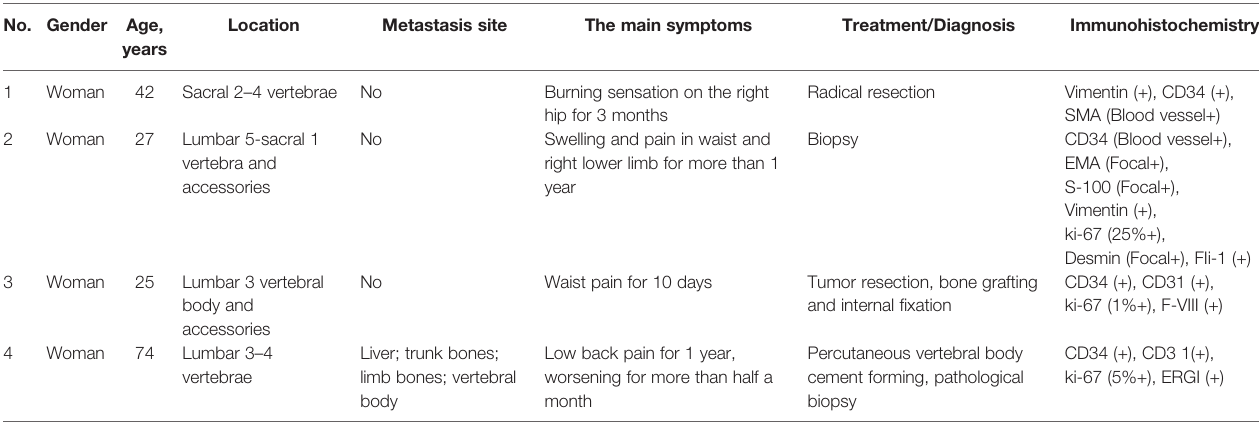
TABLE 1 | The clinical and radiological features of 4 primary SEHE